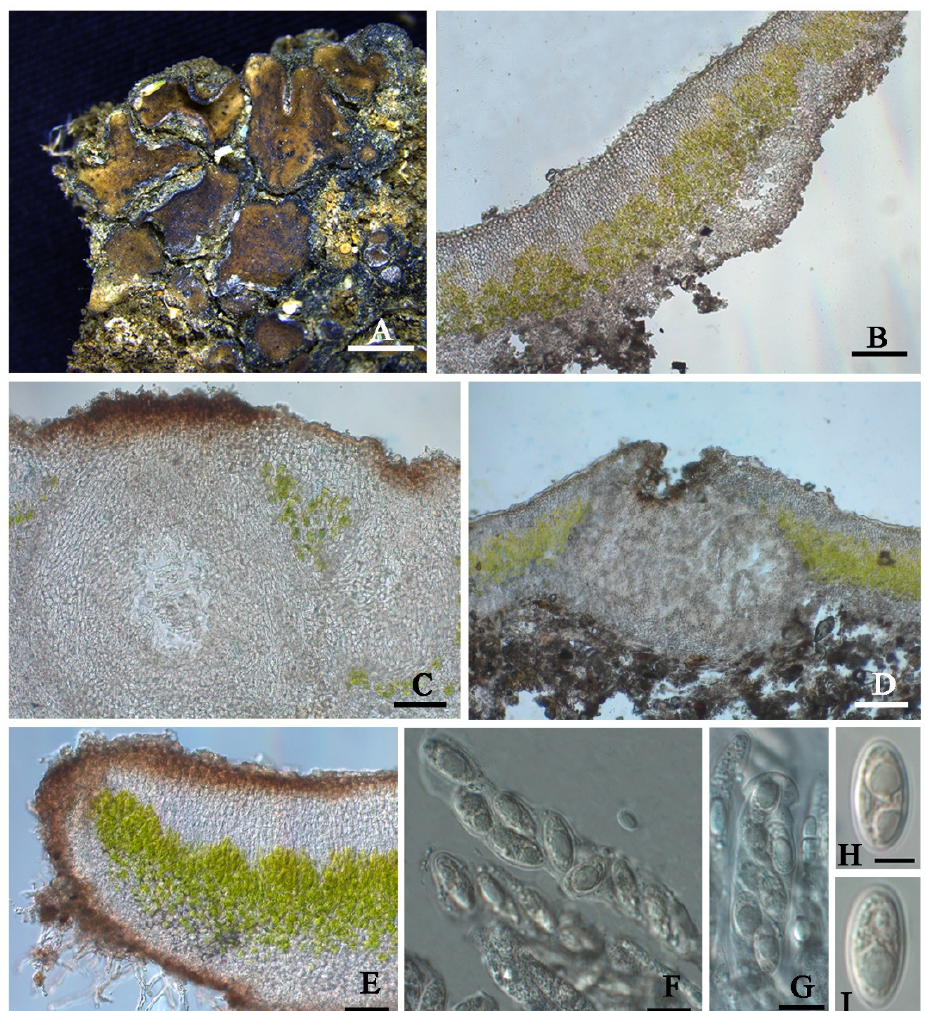
Figure 4. The thallus habit and the anatomic structure of Clavascidium sinense sp. nov (holotype HMAS-L 153946). ( A ). Squamulose thallus and immersed apothecia with the appearance of black spots. ( B ). Transversal section of thallus. ( C ). Perithecium. ( D ). Pycnidium. ( E ). Thallus section. ( F ). Uniseriate ascospores in cylindrical asci. ( G ). Biseriate ascospores in clavate ascus. ( H , I ). Ascospores. Bars: ( A ) =2 mm, ( B ) =100 µm, ( C ) =50 µm, ( D ) =2 mm, ( E ) =50 µm, ( F , G ) =10 µm, and ( H , I ) =5 µm.